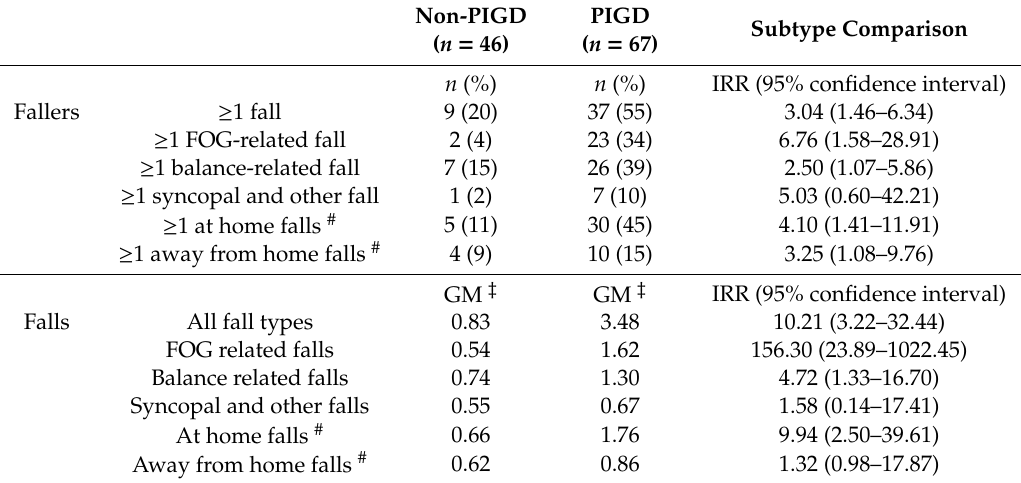
Table 3. Fall outcomes in the PD